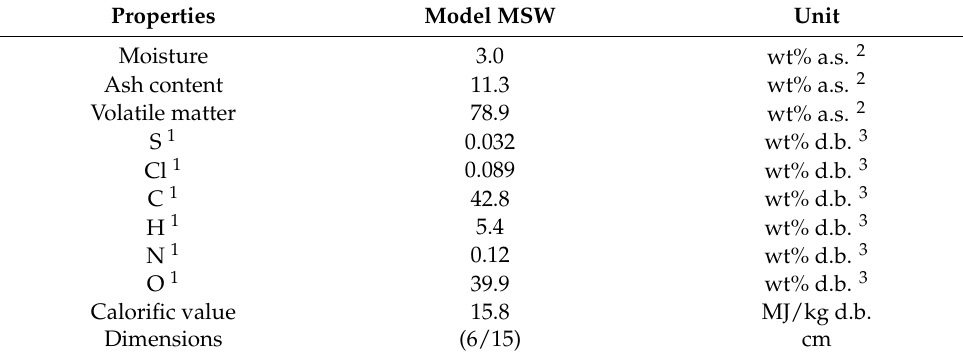
Table 1. Model MSW pellets main characteristics (EN